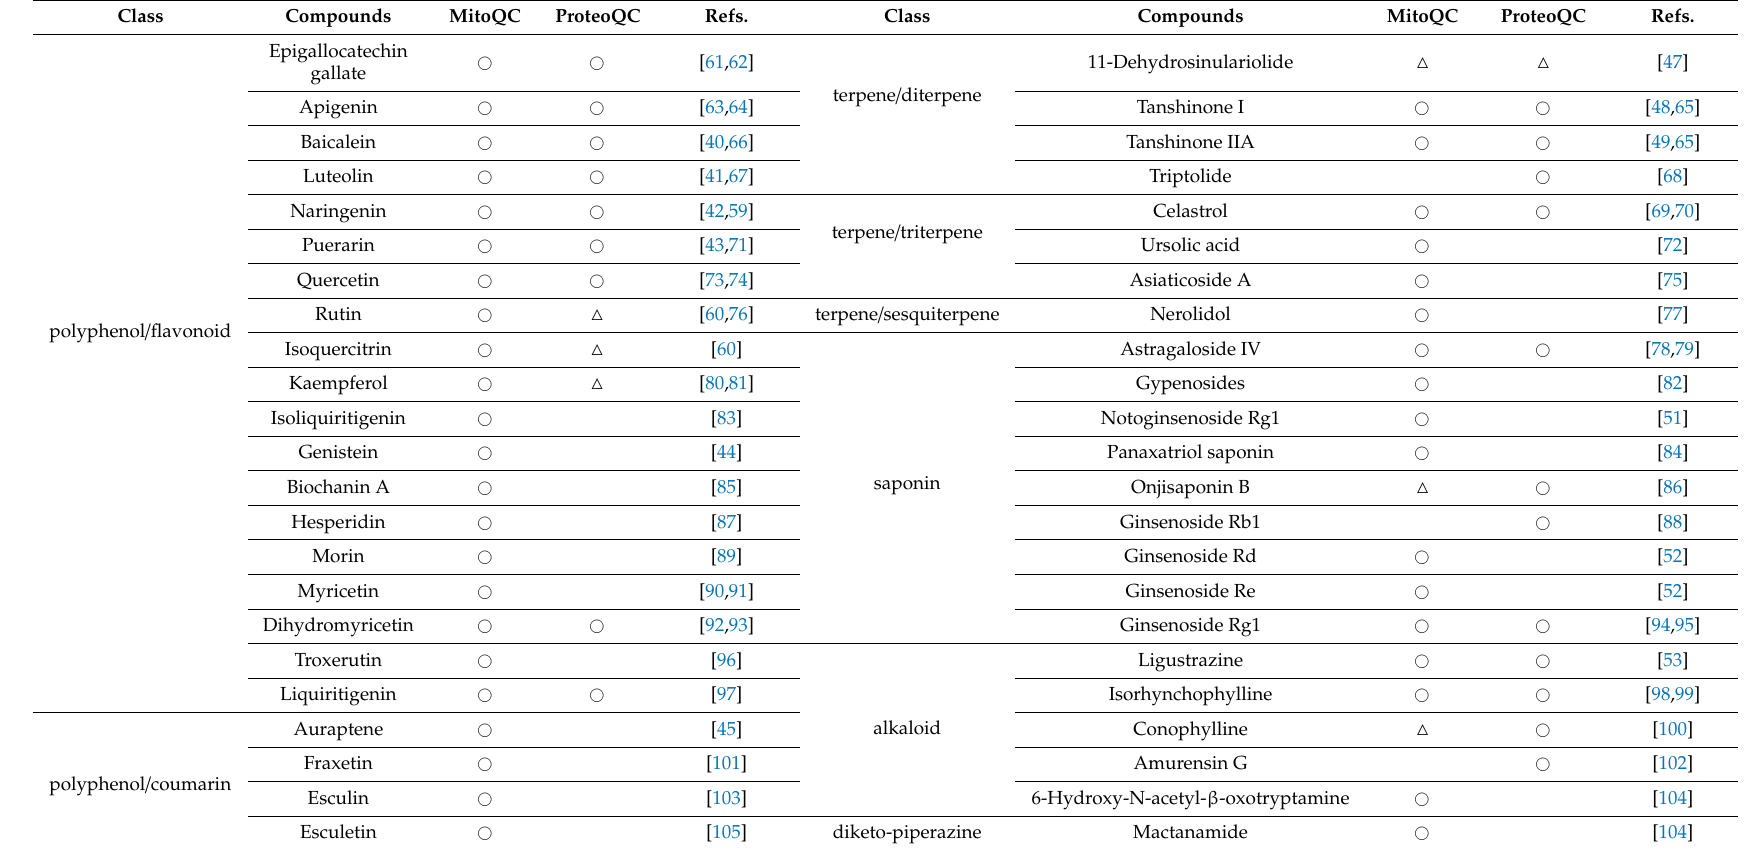
Table 1. Lead compounds from natural products having neuroprotective e ff ect in experimental PD